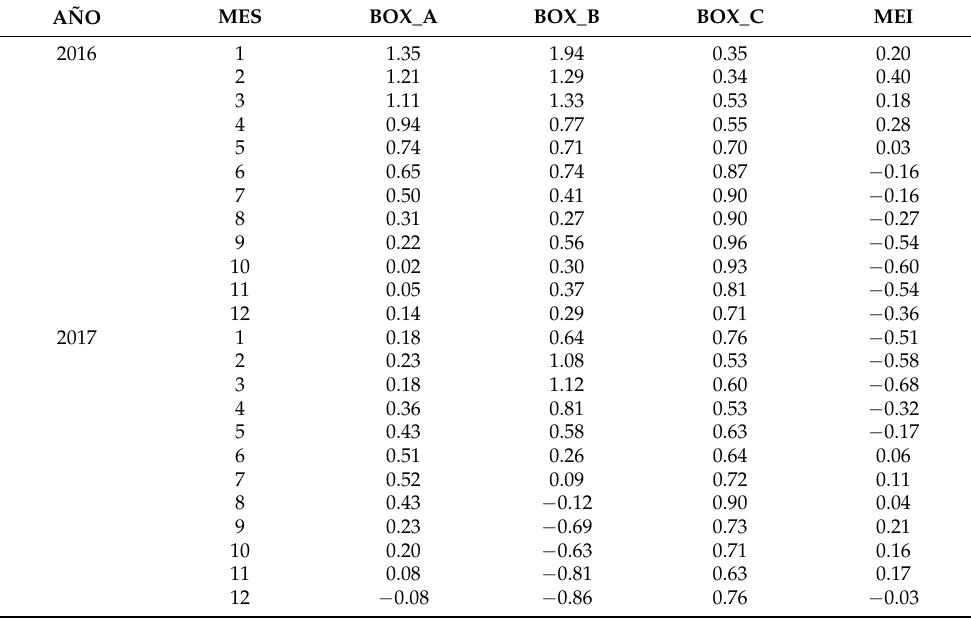
Table A2. MEI Index data, during the years 2016 and